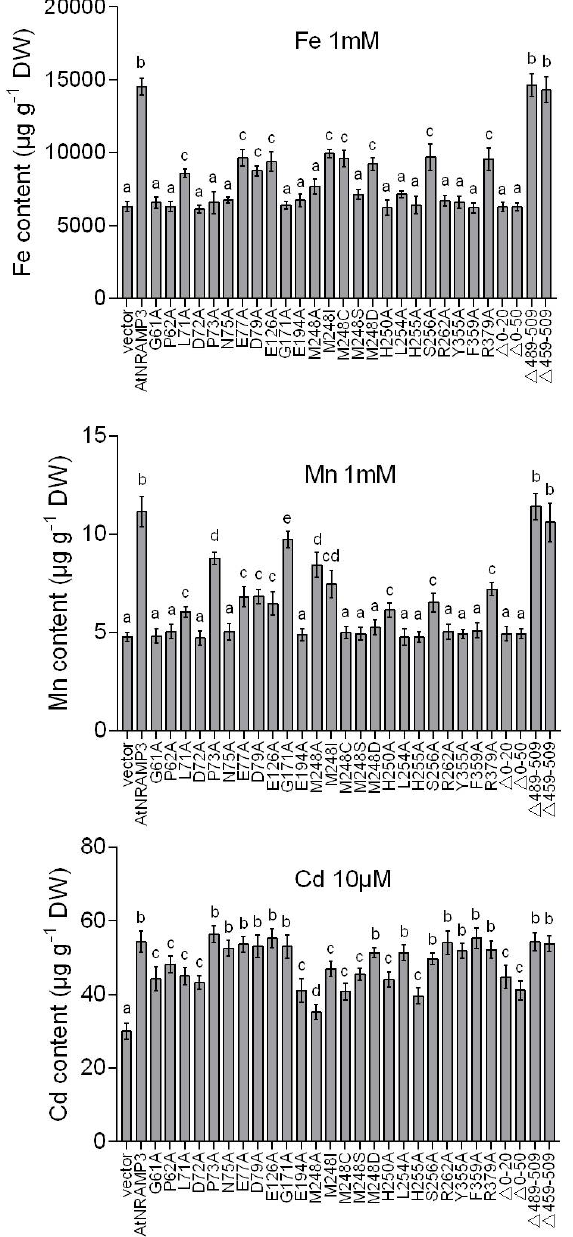
Figure 5. Concentration of Fe 2+ , Mn 2+ and Cd 2+ in yeast cells expressing wild-type AtNRAMP3 or mutated AtNRAMP3 variants. Metal accumulation in yeast cells were determined in the wild-type BY4741 (WT). BY4741 was transformed with wild-type AtNRAMP3 or mutated AtNRAMP3 variants, transformed cells were grown in liquid SD medium supplemented with 1 mM Fe 2+ , 1 mM Mn 2+ or 10 μM Cd 2+ at an initial OD600 = 0.1 for 24 h. Error bars indicate the standard deviations of three independent biological repeats. Means with different letters are significantly different (Tukey’s test, p < 0.05).